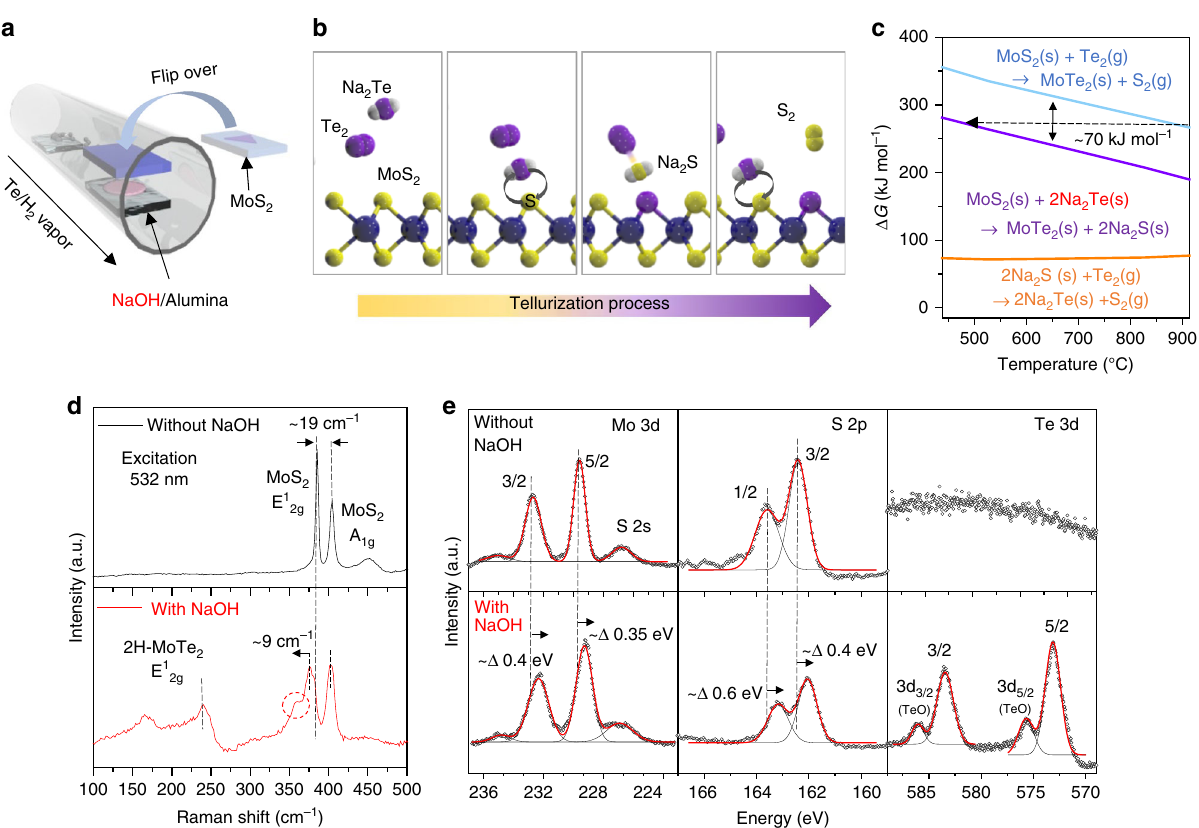
Fig. 1 Alkali-metal-assisted conversion from MoS 2 to MoTe 2 . a Schematic of the Na-assisted tellurization process. MoS 2 was fl ipped over to face the NaOH-coated substrate. b Illustration for the conversion step from Mo – S to Mo – Te via a Na-scooter. Na 2 Te, which is regarded as the most probable Na – Te compound from sodium hydroxide, plays a role as the Te carrier and catalyst for exchanging with S atoms. After exchanging S atoms with Te atoms, Na 2 S is converted to Na 2 Te under Te-rich conditions. c Gibbs free energy changes for conversion without/with Na-scooter. Δ G is reduced to around 70 kJ mol − 1 . d , e Raman spectra ( d ) and XPS taken for Mo, S, and Te ( e ) of partially tellurized MoS 2 − x Te x without/with Na-scooter at 600 °C for 30